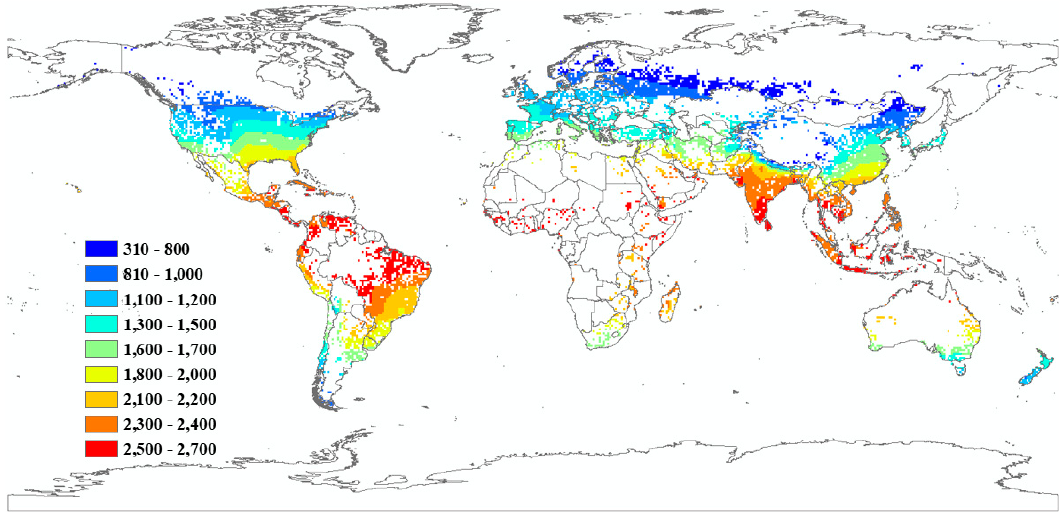
10 of 20 Figure 8. Net irrigation water requirement of GFDL model in 2050 (RCP8.5). The same irrigated area than in 1960 is used the same in figure 1.